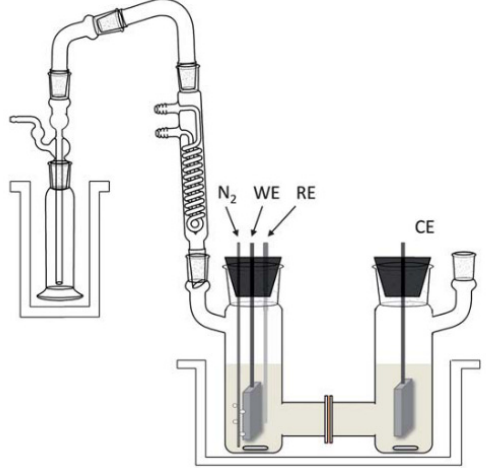
Figure 12. Electrochemical set-up with a divided H-cell, reflux condenser and cryo-trap; working electrode (WE), reference electrode (RE), counter electrode (CE). Reproduced with permission from ref [134]. Copyright 2013 The Royal Society of